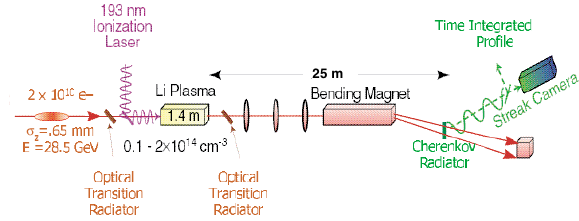
FIG. 3. (Color) Schematic of E-162 experiment layout. The diagram is not to